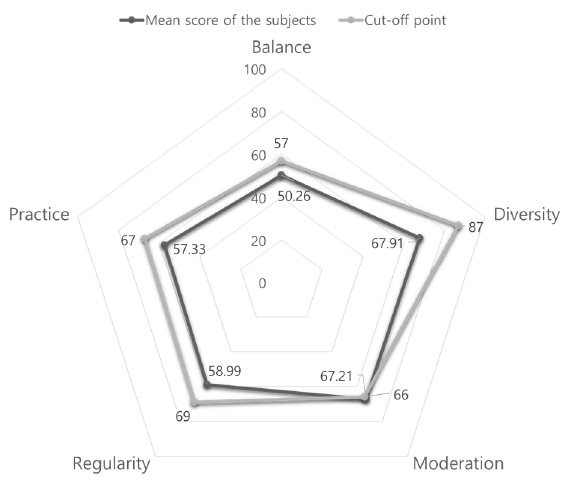
Figure 2. NQ sub-factor scores and their cut-off points ( n =